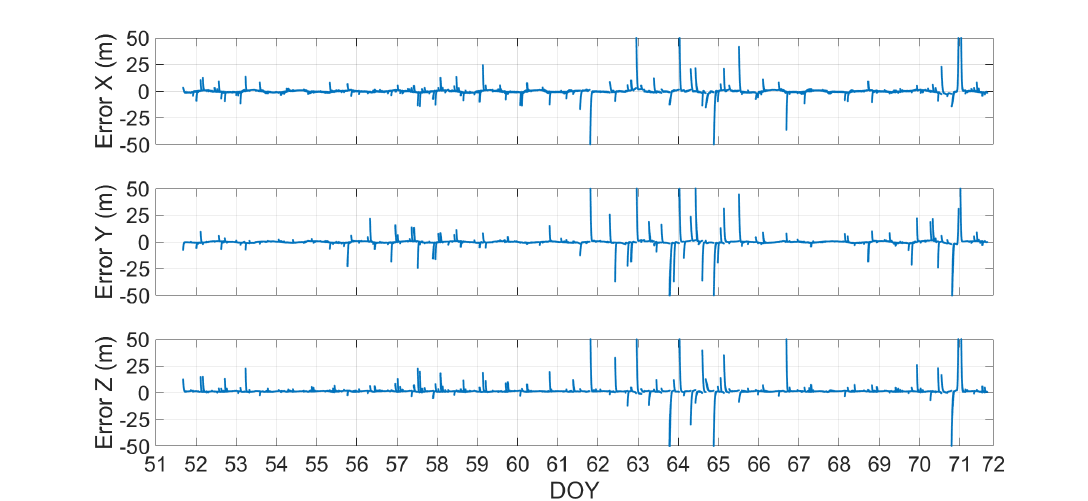
Figure 16. Orbital error of the Milena (E14) satellite plotted versus time. The ticks on the x-axis are spaced 86,400 s (equal to one day); in this way, each tick corresponds to a